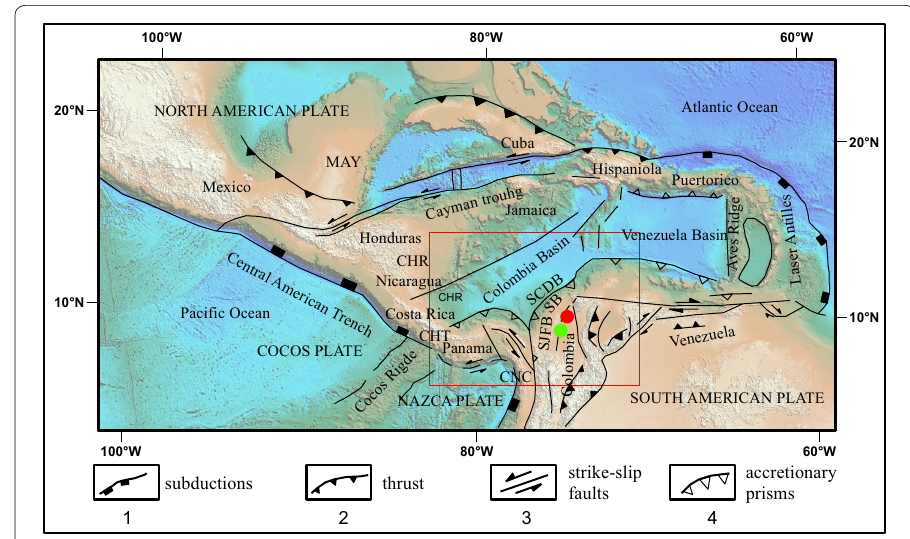
Fig. 1 Present configuration of the Caribbean plate (modified from Giunta and Orioli 2011). CHC: Choco; CHR: Chorotega; MAY: Maya; CHT: Chortis; SCDB: South Caribbean Deformed Belt; SB: Sinu Belt; SJFB: San Jacinto Folded Belt; COBA: Eastern Mountain Range of the Andean Block. The red and green dots correspond respectively to the Plato Basin, and to the San Jorge basin. The red inlay indicates the study